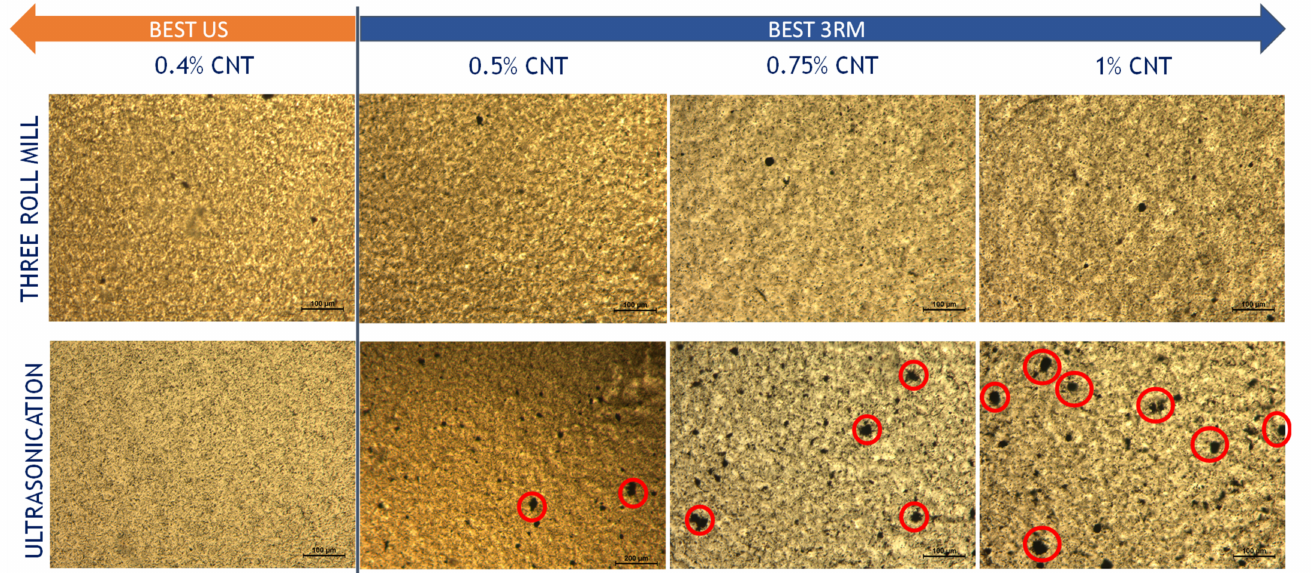
Figure 3. TOM images of the CNT-PDMS mixtures as a function of nanoparticle content and disper- sion procedure. The areas highlighted in red denote the presence of larger CNT